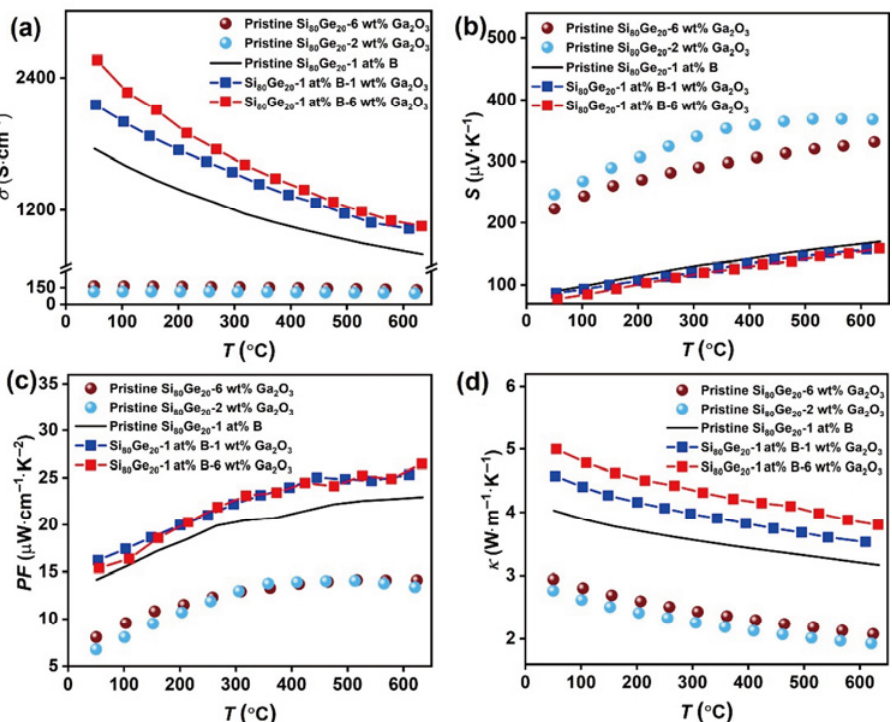
Fig. 2 (a)  , (b) S , (c) PF , and (d)  for Si 80 Ge 20 of pristine Ga 2 O 3 -composited (scatter plots), B-doped (line plots), and Ga 2 O 3 and B co-doped (composited) (point-line plots)